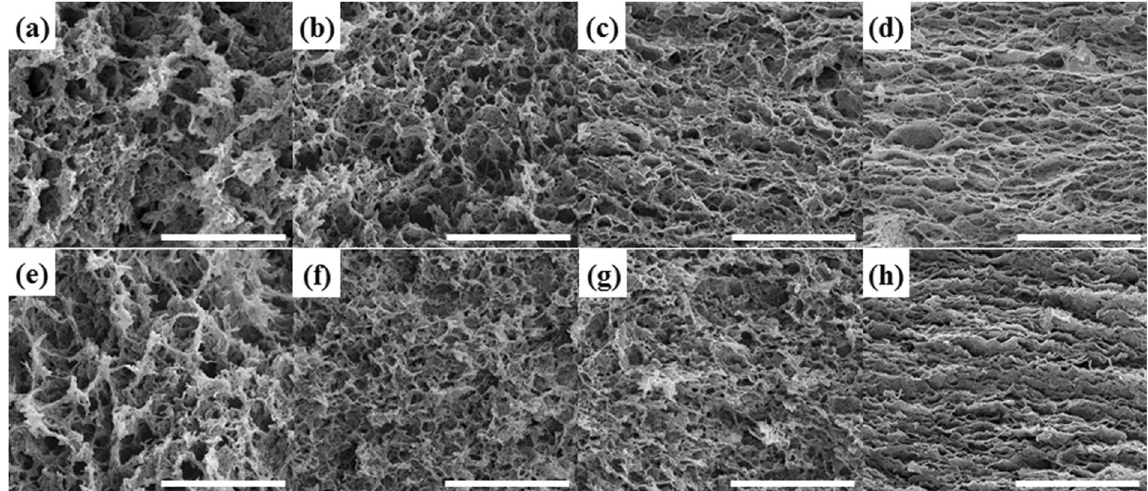
Figure 2. Microscopic morphology of the graphene aerogels prepared by hydrothermal reduction of graphene oxide (GO) dispersions with different concentrations ( a–d ) before and ( e and f ) after heat-treatment at 1500 °C under N 2 atmosphere for 1 h. C GO values of ( a and e ) 1, ( b and f ) 2, ( c and g ) 5, and ( d,h ) 10 mg∙mL − 1 . The scale bar is 10 µ